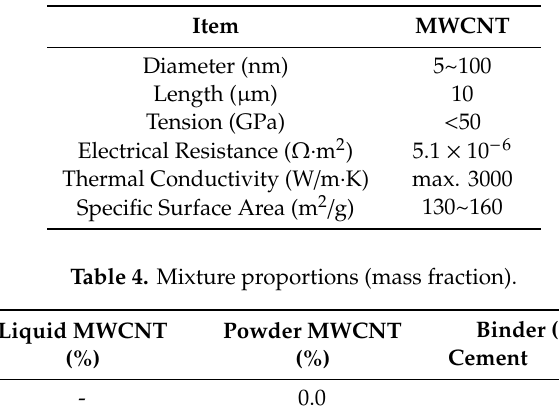
Table 2. Composition of liquid multi-wall carbon nanotubes (MWCNTs) (mass fraction).